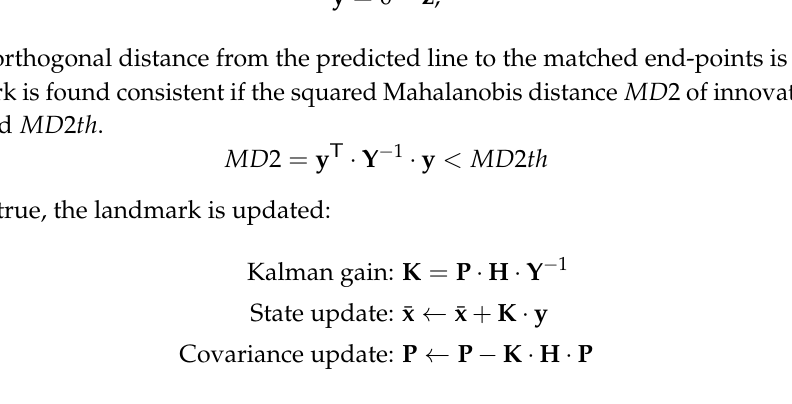
than a threshold MD 2 th